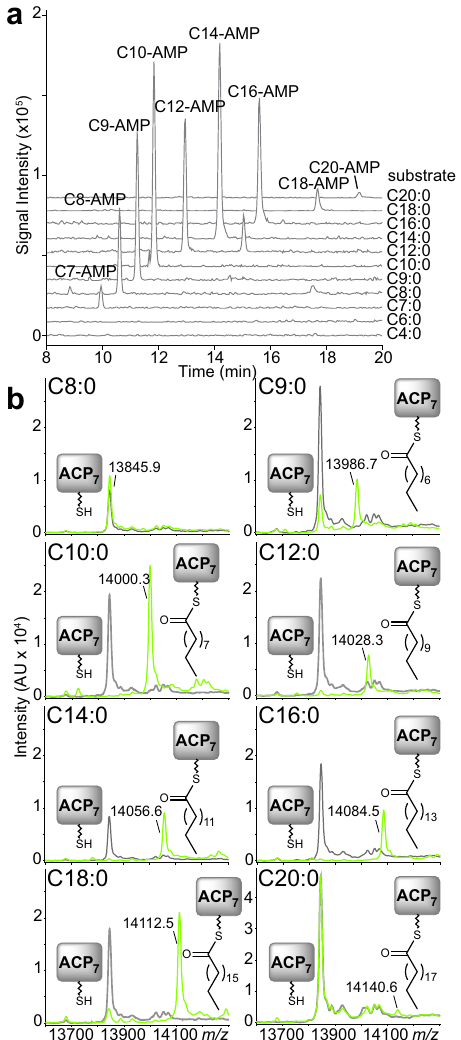
Fig. 5 In vitro activity of PKAL-1 against fatty acid substrates. a Activity of PKAL-1 towards fatty acids of various lengths in the presence of ATP and CoA. Extracted ion chromatograms are representative of at least three independent experiments. The identities of the peaks were veri fi ed based on their masses in both positive and negative modes, as well as their UV spectra. The catalytic mutant PKAL-1(K488A) did not show any product formation. The inability of PKAL-1 to form CoA-thioesters was veri fi ed with synthetic standards (Supplementary Fig. 16). b MALDI-TOF analysis of the holo-ACP 7 domain from NRPS-1 incubated with PKAL-1 (light green) or PKAL-1(K488A) (gray), fatty acids of various lengths, and ATP. MALDI spectra are representative of at least three independent